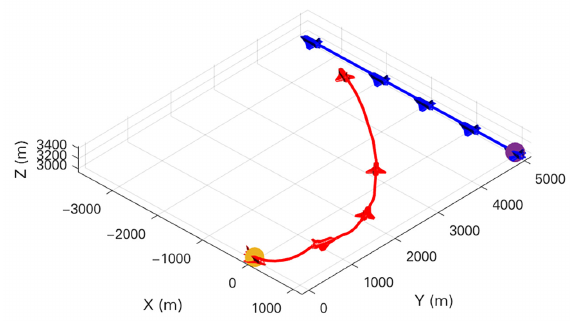
Figure 10. The two UCAV tracks in the later training period in case